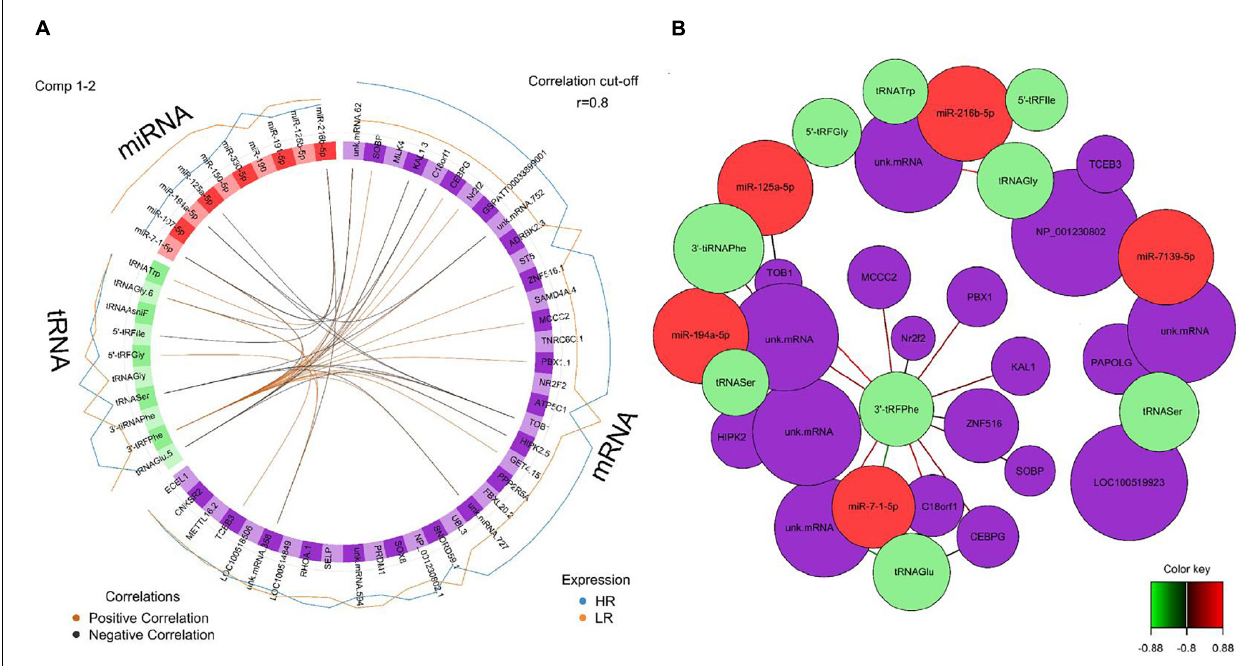
FIGURE 8 | (A) Circos plot of mRNA, miRNA, and tRNA linked to coping behavior haplotype groups in the hippocampus. Positive correlations are indicated by brown-colored connectors, while black connectors indicate negative correlation between mRNA, miRNA, and tRNA. Blue and orange colored lines in the outer circle highlight expression levels in either high (HR) or low (LR) reactive coping group. (B) Network visualization of mRNA, miRNA and tRNA panels indicating correlated variables in the hippocampus ( r > | 0.80|). Purple colored nodes represent mRNA, red nodes indicate miRNA and green nodes highlight tRNA biomarkers. Correlation between nodes is indicated by edge color as shown in the color key. Negative correlation is depicted by green edges, while red edges represent positive correlation.